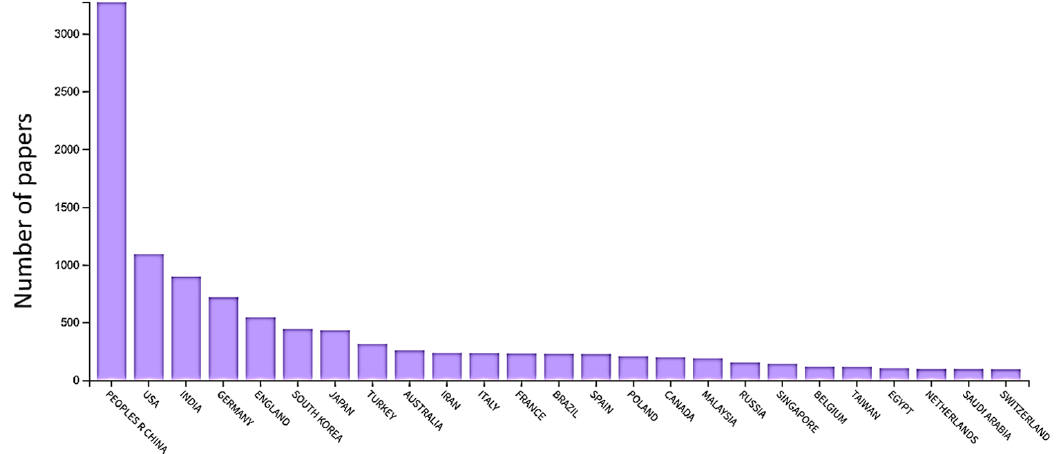
Figure 6. Number of papers by country produced on the FML and machining area.